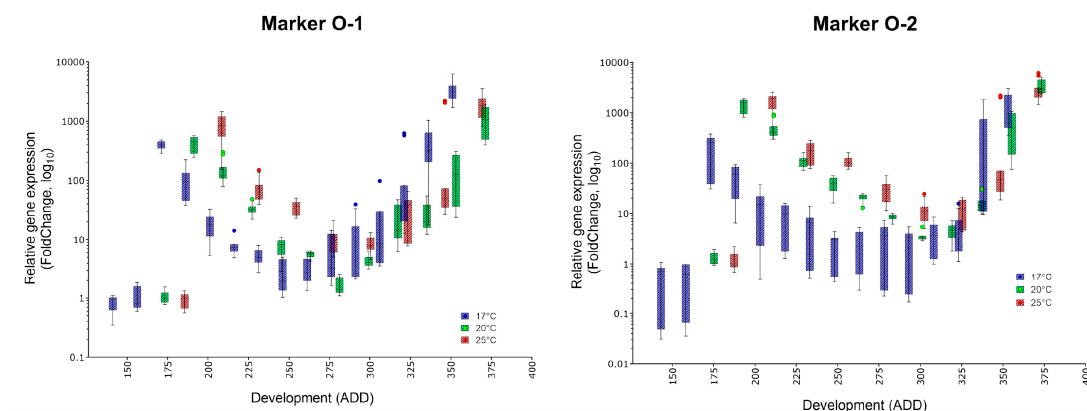
Figure 1. Tukey plots visualizing the expression level of differentially genes showing a demarcated area of higher gene expression during metamorphosis. Fold change (FC) values are plotted against pupal age (ADD, temperature threshold for development 2 °C) Blue boxes represent data from the 17 °C study, green boxes represent 20 °C data and red boxed represent 25 °C data. First sampling at each temperature represents the white prepupal stage, at which a FC of one would occur when Marker A is applied (not depicted).